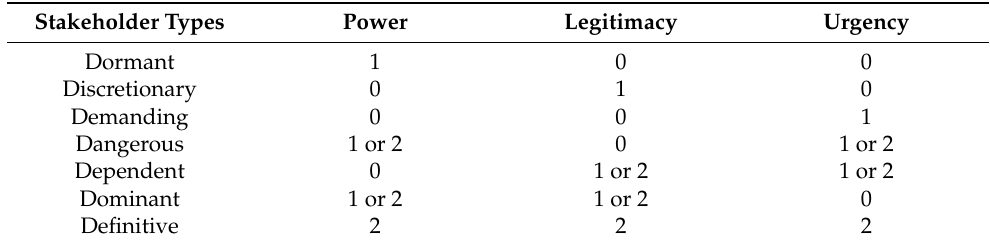
Table 2. Stakeholder’s